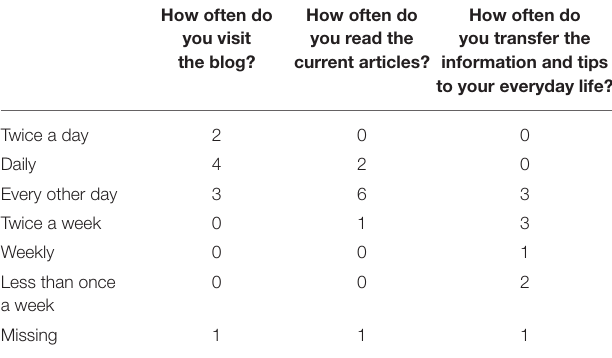
TABLE 3 | Frequency of blog usage (self-report by the